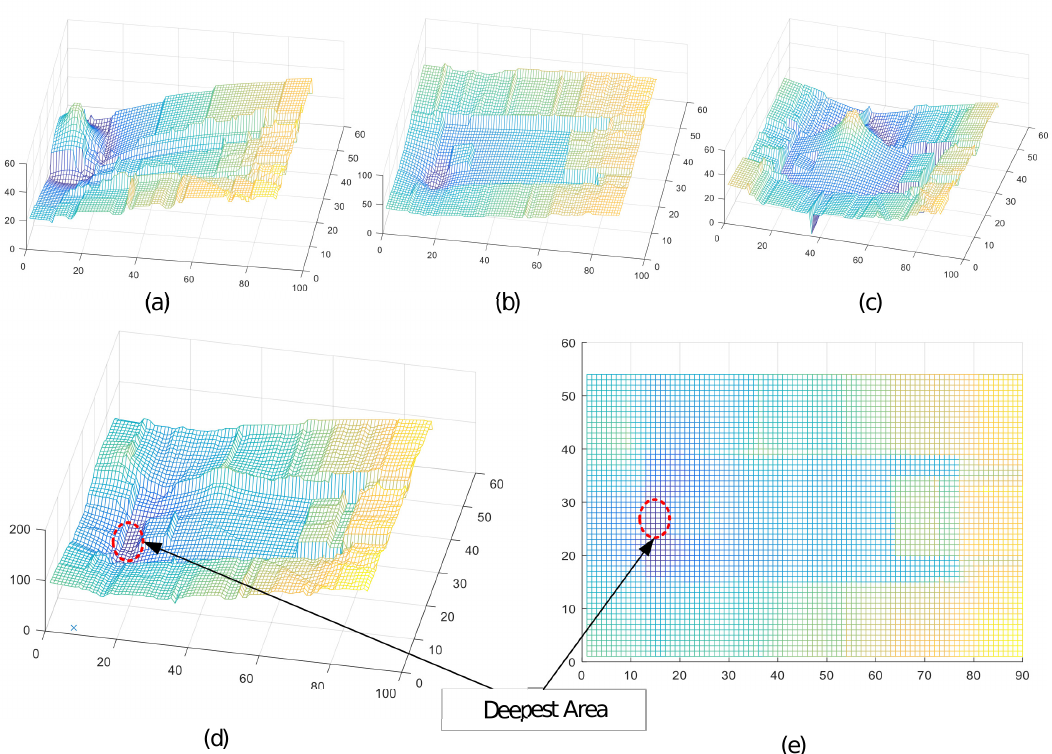
Figure 6. Slightly different approach from the binary map for reducing the thresholding calculation: ( a ) expected target location of the lowest valley with respect to AP, A; ( b ) expected target location of the lowest valley with respect to AP, B; and ( c ) for AP, C; ( d , e ) combination of the RSSI valleys and deepest region of the expected target